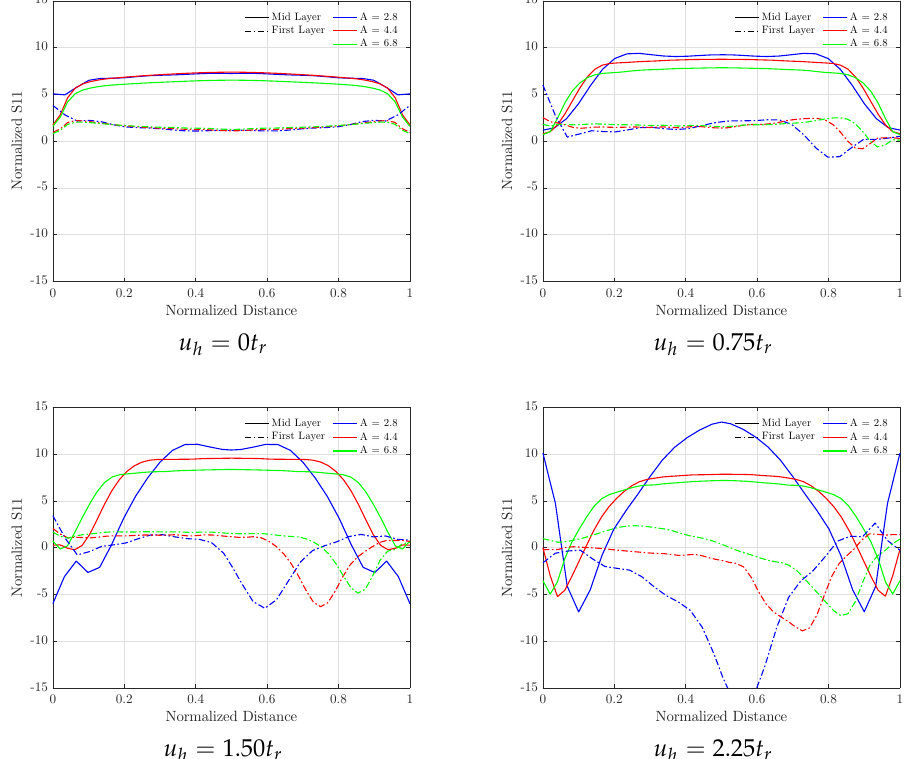
Figure 16. Axial stress S11 on the reinforcement along the symmetry axis. Effect of aspect ratio A